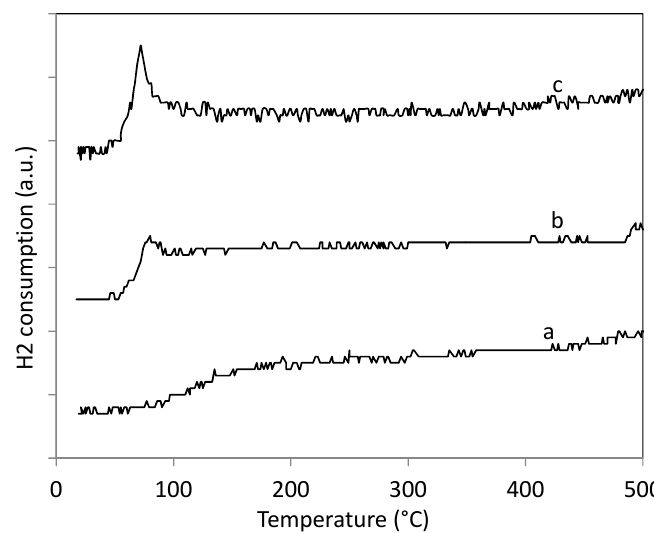
Figure 4. H 2 -TPR profiles of ( a ) Ag1Z, ( b ) Ag5Z, and ( c ) Ag10Z.